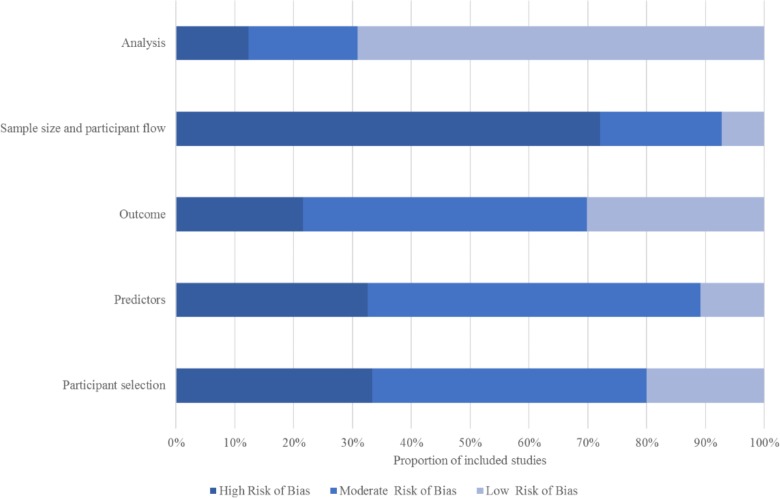
Risk of bias (% across all studies by domain).